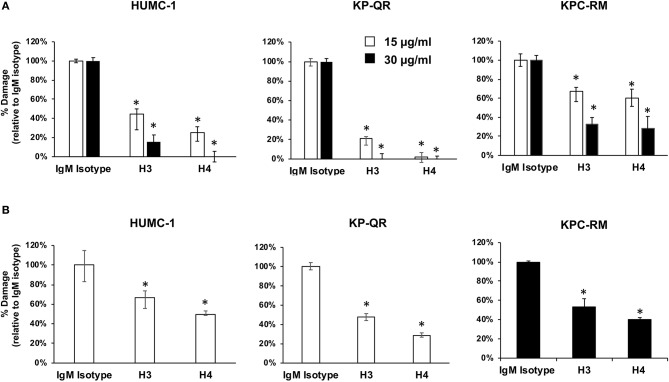
Monoclonal antibodies (mAbs) targeting Hyr1 peptide #5 prevents HUMC-1-, KP-QR-, and KP-RM-induced A549 lung alveolar epithelial cells and primary human umbilical vein endothelial cells (HUVECs) damage. HUMC-1-, KP-QR-, and KPC-RM-induced A549 cell injury in the presence of 15 or 30 μg/ml of an isotype-matched IgM, mAb H3, or mAb H4 (A). Damage to HUVECs by HUMC-1 and KP-QR (in the presence of 15 μg/ml of H3 and H4), also KPC-RM (30 μg/ml of the mAbs) (B). Cell damage was determined by 51Cr-release assay after 48 and 24 h for HUMC-1 and KP, respectively. Percentage damage was normalized to IgM isotype-matched control after subtracting spontaneous cell damage. *P < 0.001 vs. control IgM. N = 12 per group from three independent experiments.